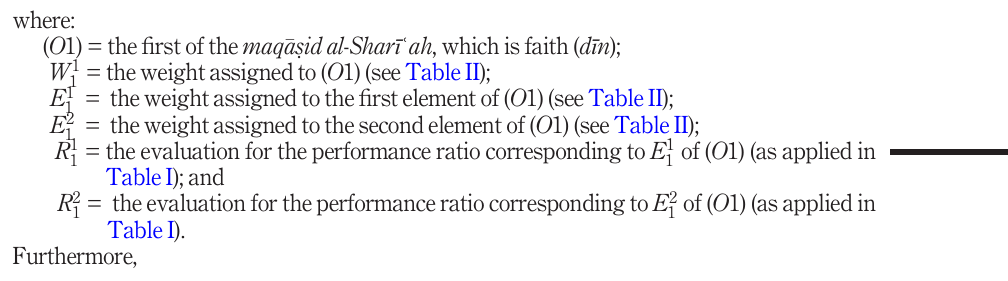
R 2 = the evaluation for the performance ratio corresponding to E 2 1